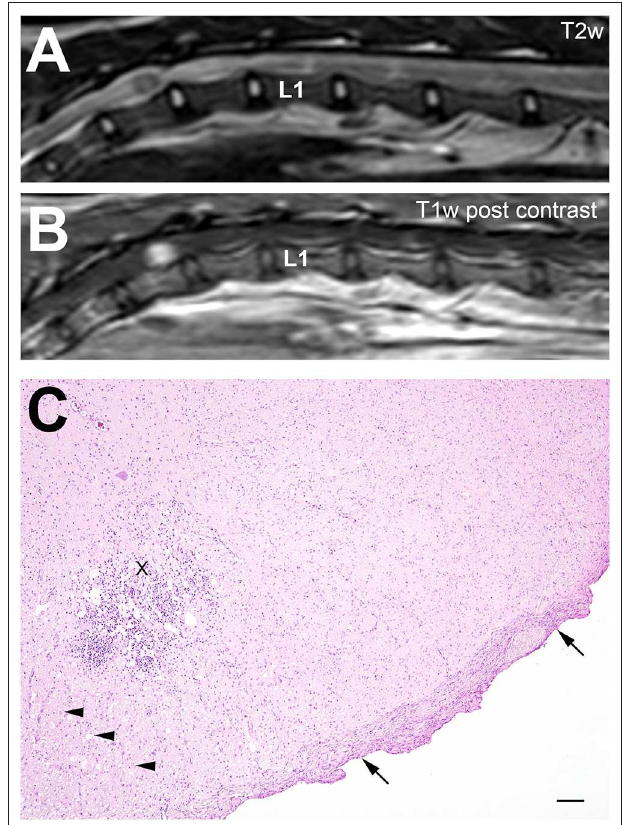
FIGURE 4 | Cat no. 4. (A,B) Magnetic resonance imaging (MRI): Midsagittal section of the spinal cord at the thoracolumbar junction in T2w (A) and T1w post-contrast (B) sequences. First lumbar vertebra is marked with L1. Note the intramedullary hyperintense signal (A) from T11 to L1 and the focal contrast enhancement at the level of T12 (B) . (C) Histopathology: Thoracic spinal cord showing a focally extensive severe lympho-histiocytic inflammation (X) associated with dilatation of myelin sheaths and swollen axons (arrowheads). In addition, a severe meningeal fibrosis is present (arrows). HE, bar = 100 µ